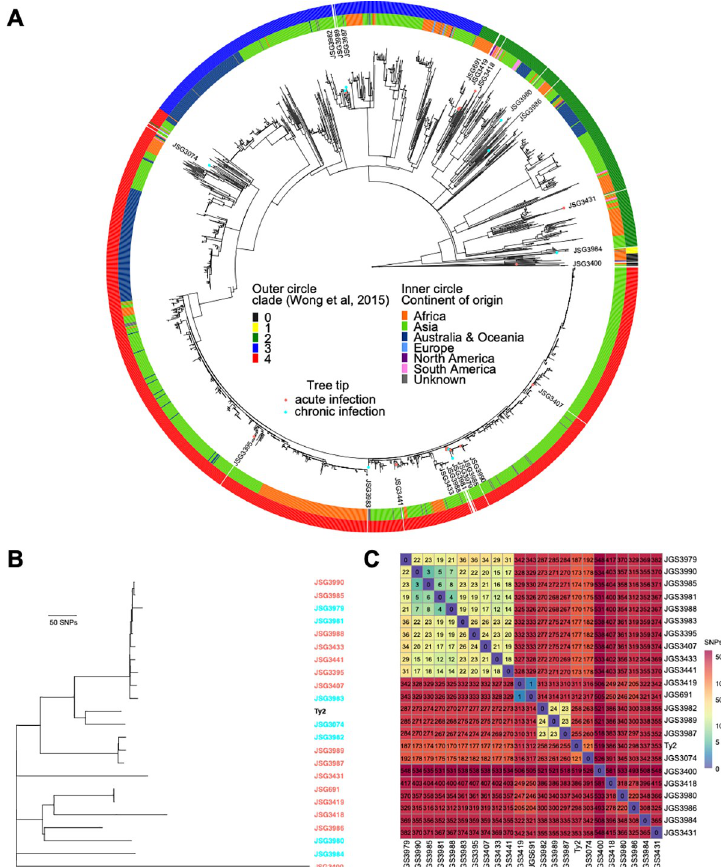
Fig 1. Phylogenetic relationship of S . Typhi isolates. ( A ) Maximum likelihood phylogenetic tree based on core genome sequence variation. This shows the relationship of S . Typhi strains used in this study in the context of a global collection of S . Typhi strains reported in (31). ( B ) Maximum likelihood phylogenetic tree showing the relationship of S . Typhi clinical isolates and S . Typhi Ty2 based on core genome sequence variation. ( C ) Single nucleotide polymorphism distance matrix and heatmap of isolates in this study. There was no apparent clustering of the sequenced isolates by the acute versus chronic infection status of the